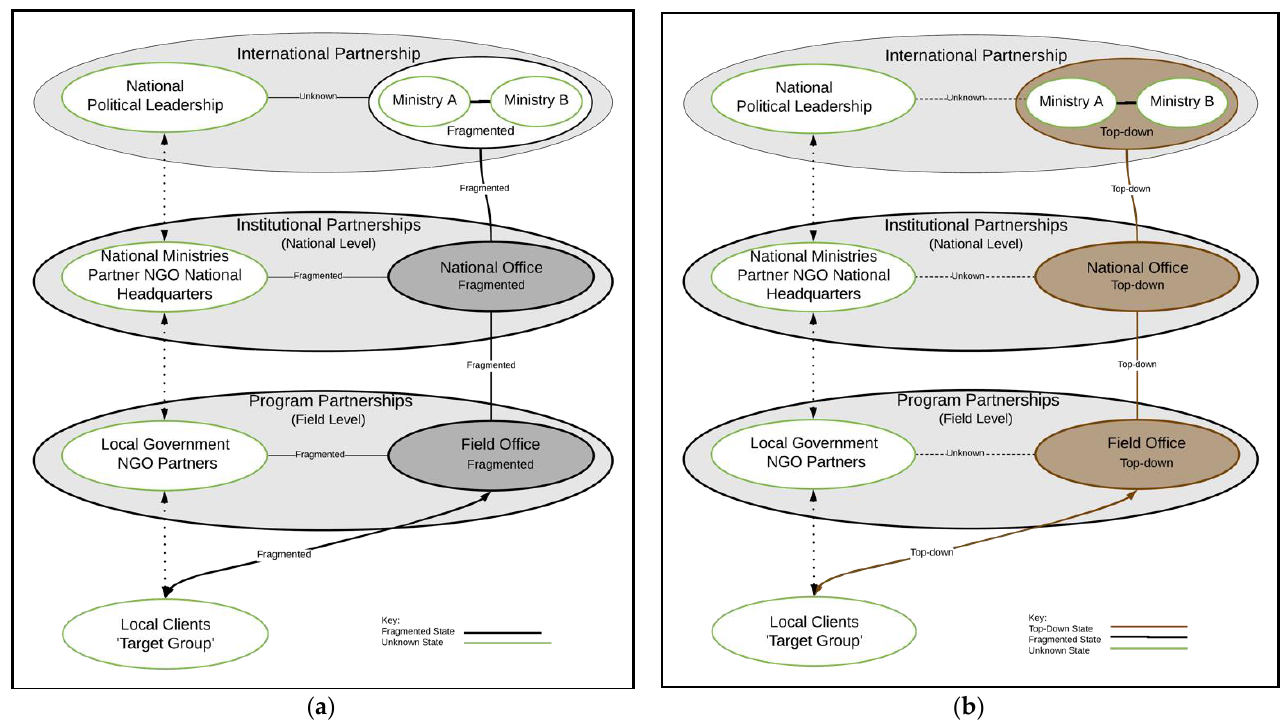
Figure 8. ( a ) Before: The partnership network in the Fragmented state; ( b ) Partnership network in the Top-down state.